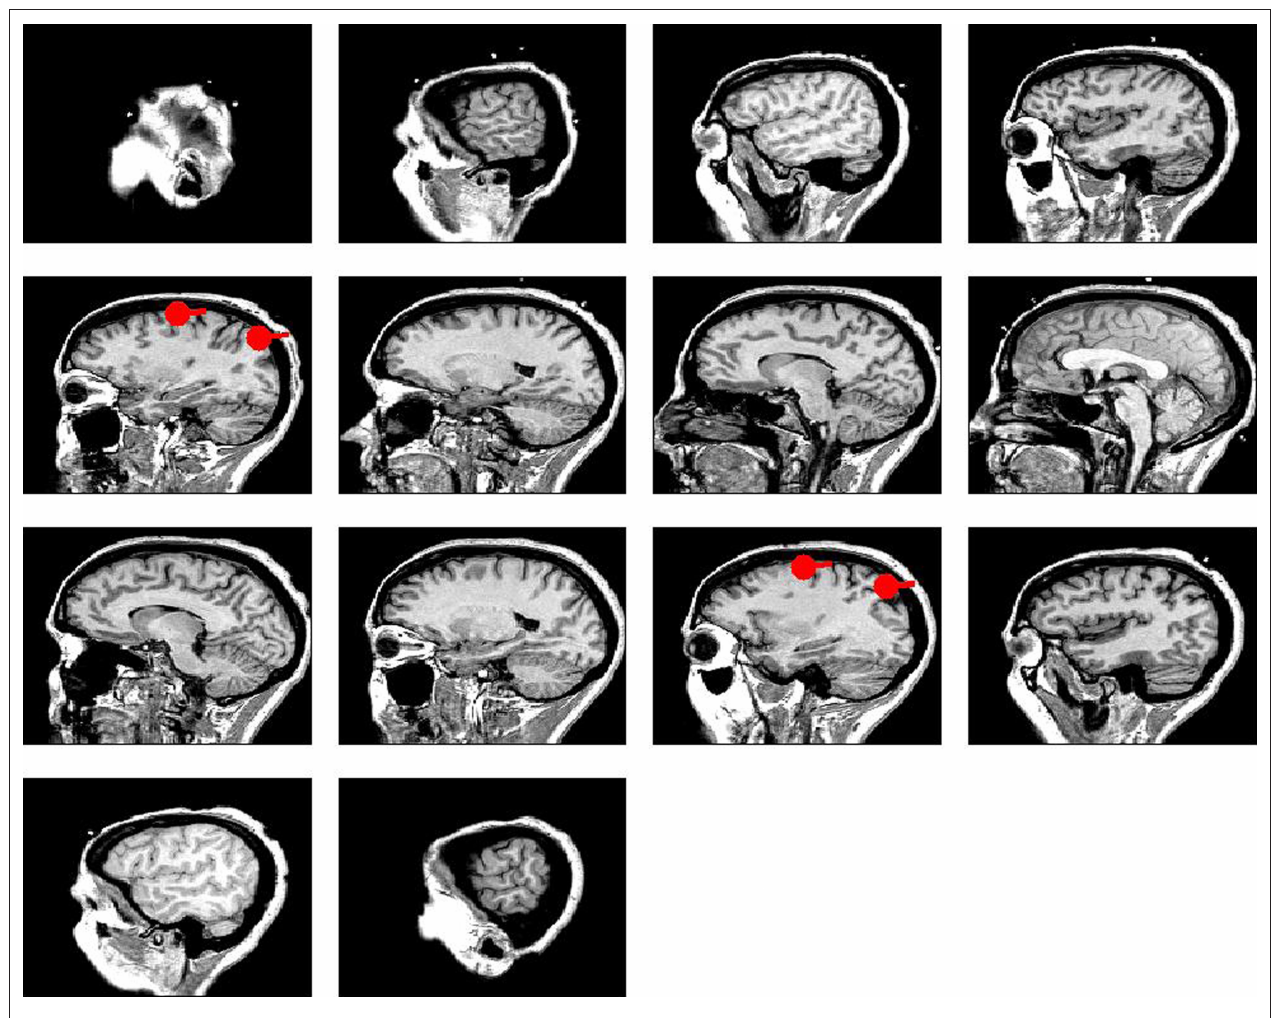
FIGurE 1 | Four dipolar sources overlayed on